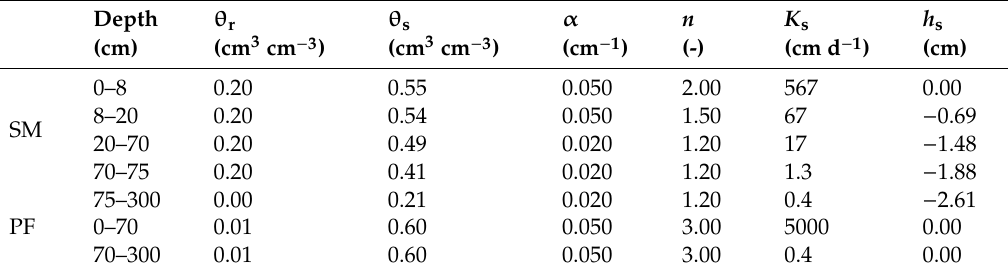
Table 1. The soil hydraulic parameters † used for the two-dimensional dual-continuum model. SM and PF refer to the soil matrix and preferential flow domain, respectively.